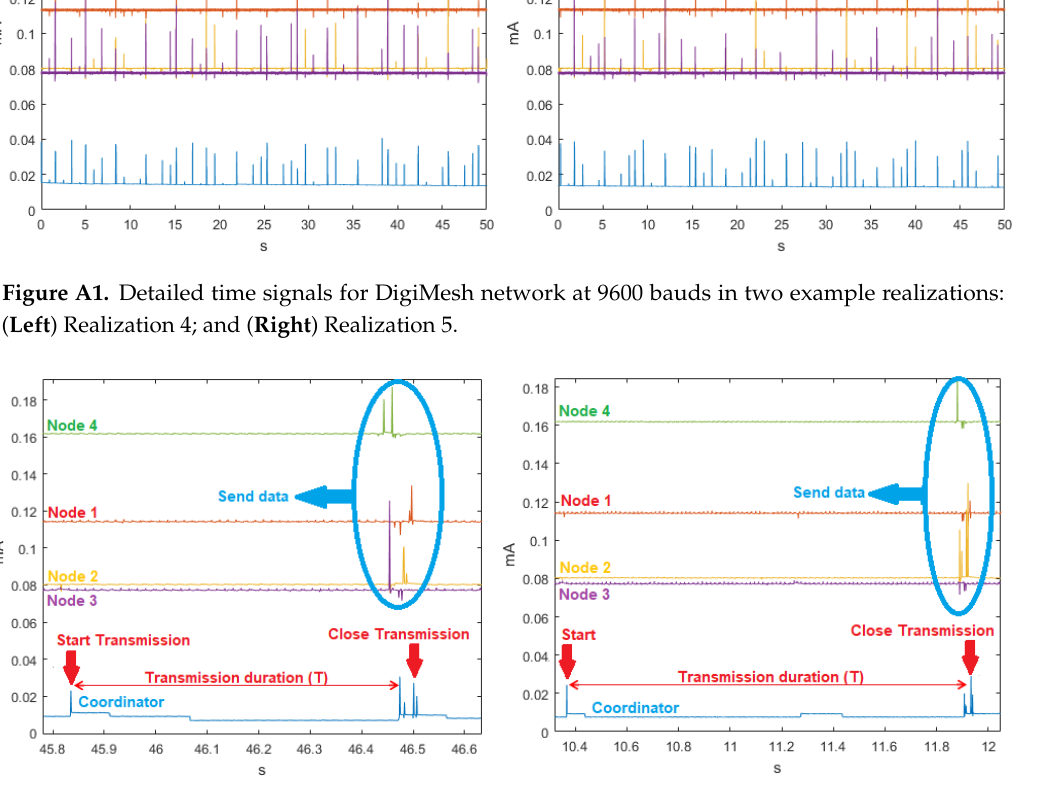
Figure A2. Closer details signal sections for DigiMesh network, and spike sequence of two realizations at 9600 bauds: ( Left ) Realization 9 with T = 0.68 s; and ( Right ) Realization 10 with T = 1.57